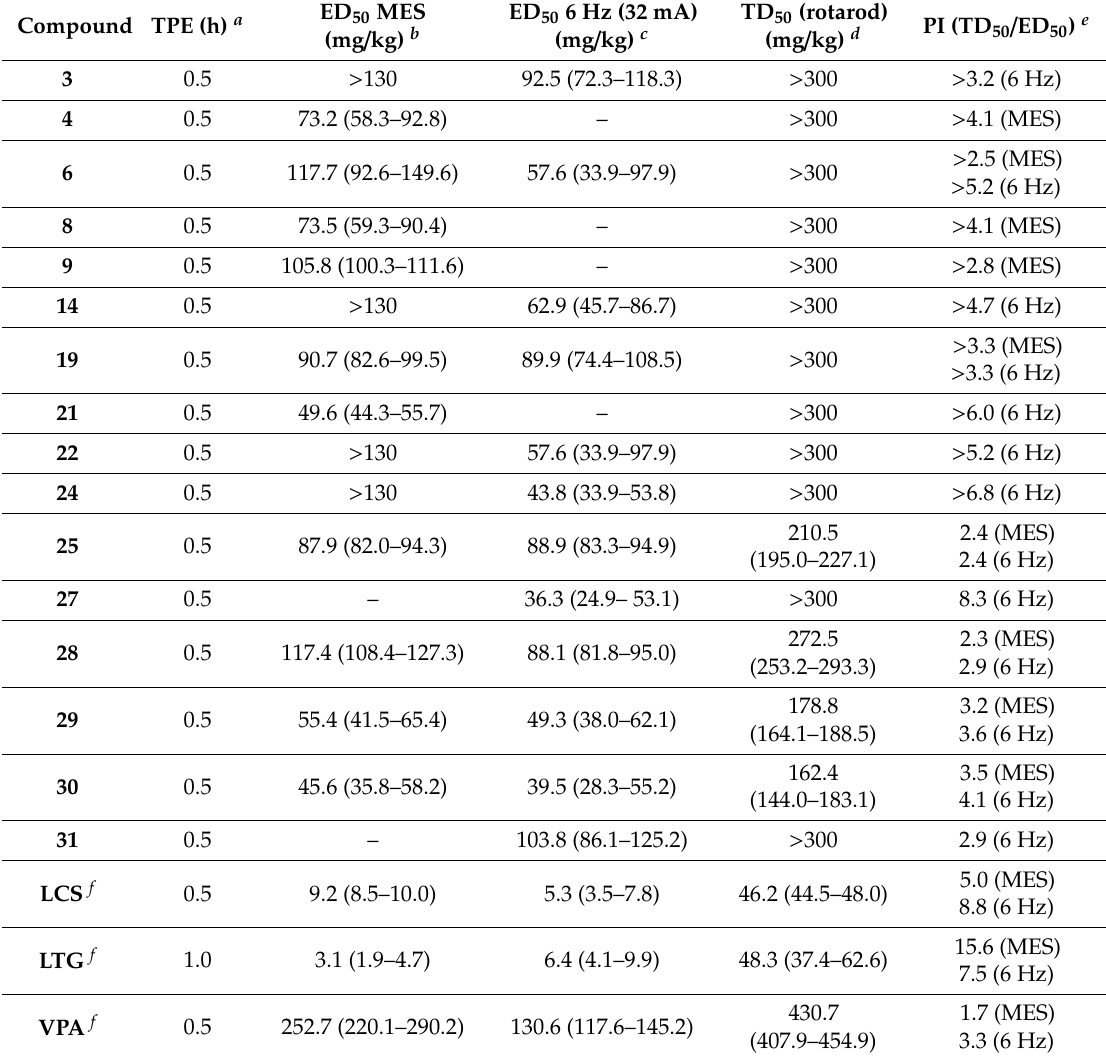
Table 1. The quantitative pharmacological parameters: median e ff ective dose (ED 50 ), median toxic dose (TD 50 ), and protective indexes (PIs) in mice intraperitoneally (i.p.) injected. Compound TPE (h)